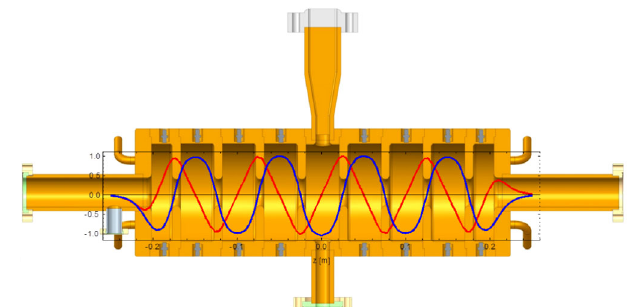
FIG. 23. Measured phase at the linac probe and low-level rf (LLRF) output phase with phase feed-forward on (left) and off (right). The fast noise in the probe signal phase is the rf phase jitter, which is discussed in Sec. V I.